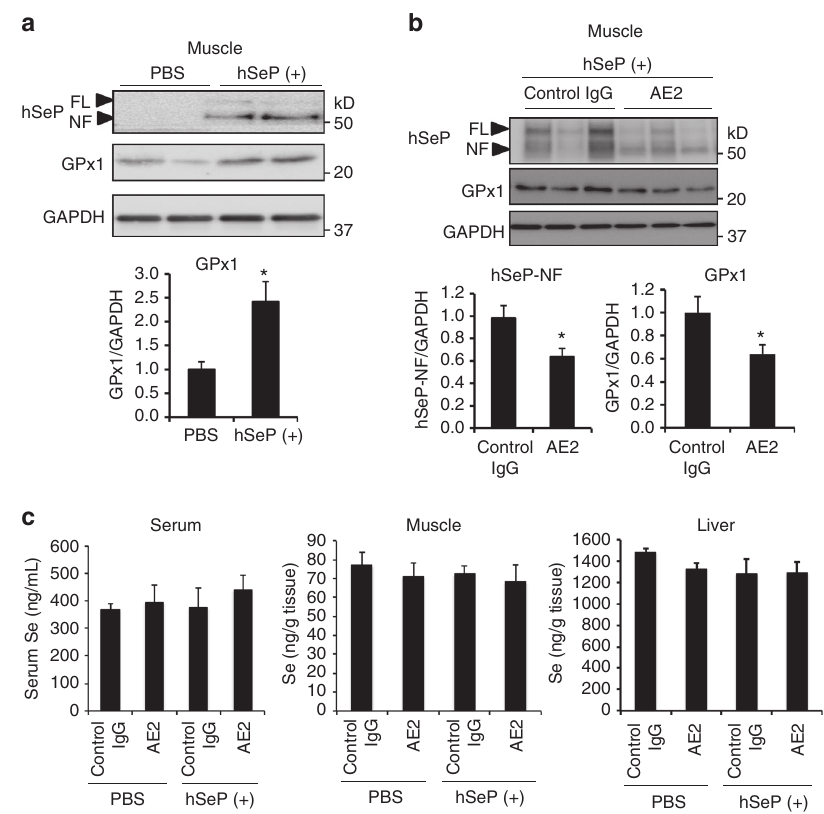
Fig. 2 Effects of AE2 mAb on cellular uptake and Se-supply activity of SeP in vivo. a Following the scheme shown in Supplementary Fig. 4a, C57BL/6 J mice (female, 9 weeks old) were injected twice with puri fi ed hSeP (1 mg/kg intraperitoneally) or vehicle control (PBS intraperitoneally) 12 and 2 h before sampling. After perfusion with saline, excised skeletal muscle tissues were homogenized and protein samples were analysed by western blotting with anti- hSeP Ab BD1 and anti-GPx1 Ab ( n = 3, means ± s.e.m.). b , c AE2 and control rat IgG1 (20 mg/kg intraperitoneally) were administered 2 h before the fi rst injection of hSeP. Two hours after the second injection of hSeP, muscle tissues were homogenized and protein samples were analysed by western blotting ( b , n = 11 – 13, means ± s.e.m.). * P < 0.05, Student's t- test ( a , b ). Se was assayed in serum and homogenate samples of muscle and liver, as described in the Methods ( c , n = 5 – 7, means ±